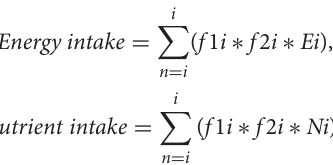
f 1: food frequency relative weight, f 2: food intake weight, E: energy content and N: nutrient content; i = 1–25 (25